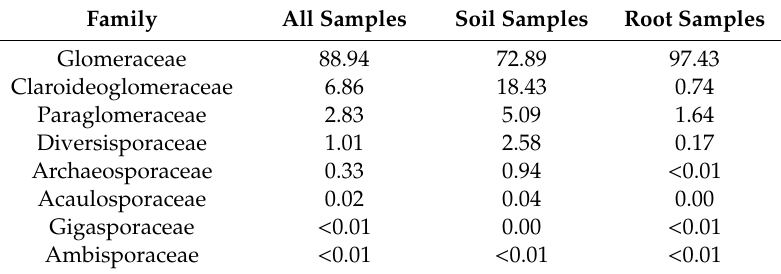
Table A2. Significance of PCNM axes on AM fungal community composition measured via PERMANOVA (999 permutations and Euclidean distance as measure of dissimilarity). Significant p -values are highlighted in bold.